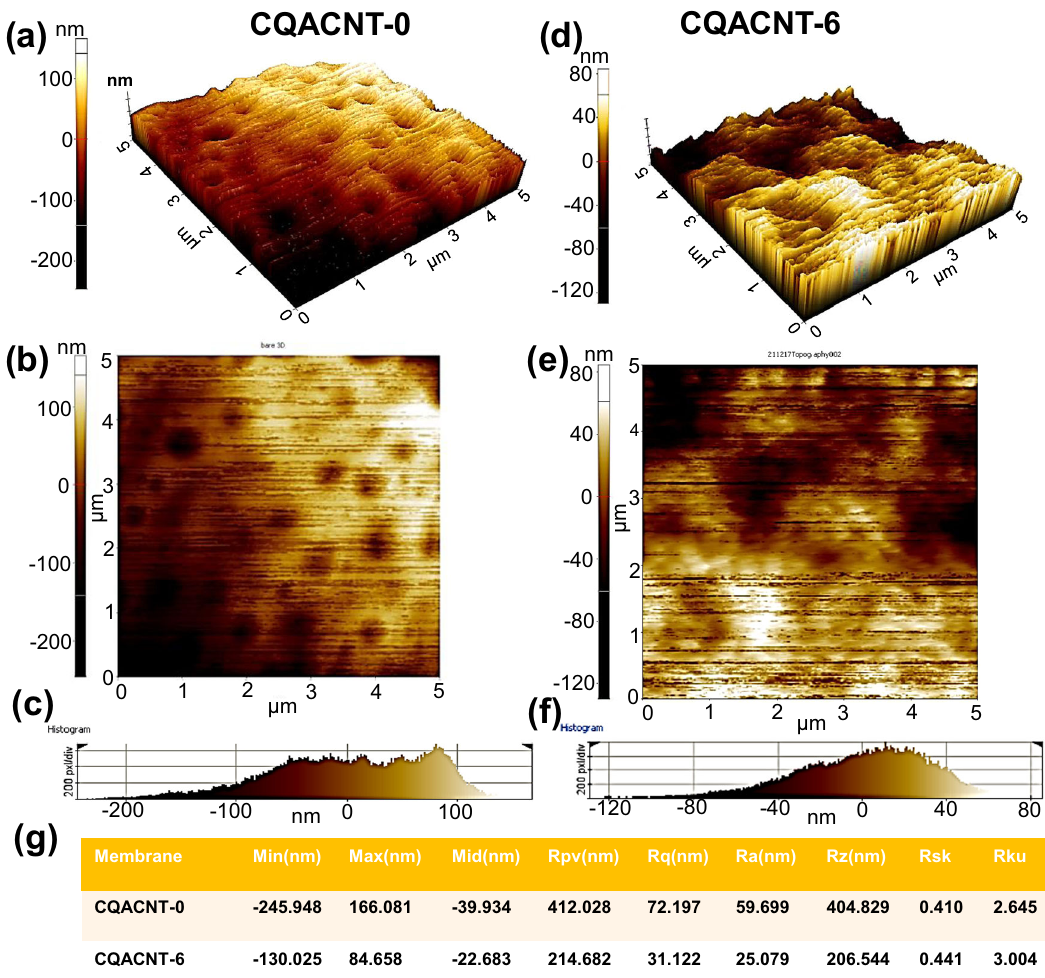
Fig. 5 AFM images of fabricated membranes. a 3D image of CQACNT-0 membrane; b 2D image of CQACNT-0 membrane; c Histogram of CQACNT-0 membrane; d 3D image of CQACNT-6 membrane; e 2D image of CQACNT-6 membrane; f Histogram of CQACNT-6 membrane; g Surface roughness of CQACNT-0 and CQACNT-6